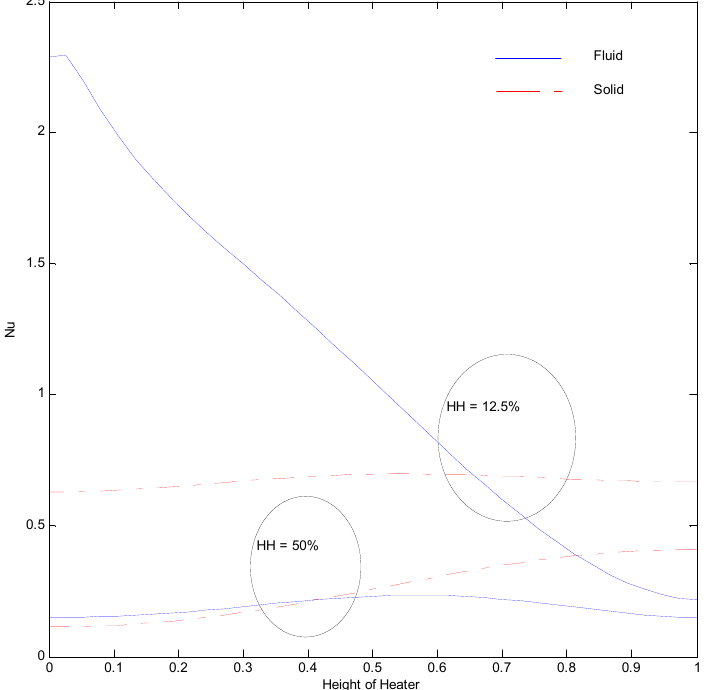
Figure 29. Nusselt number for inner strip at Ra = 100, H = 5, Kr = 1, Rd = 0 for strip at x = 0.75.